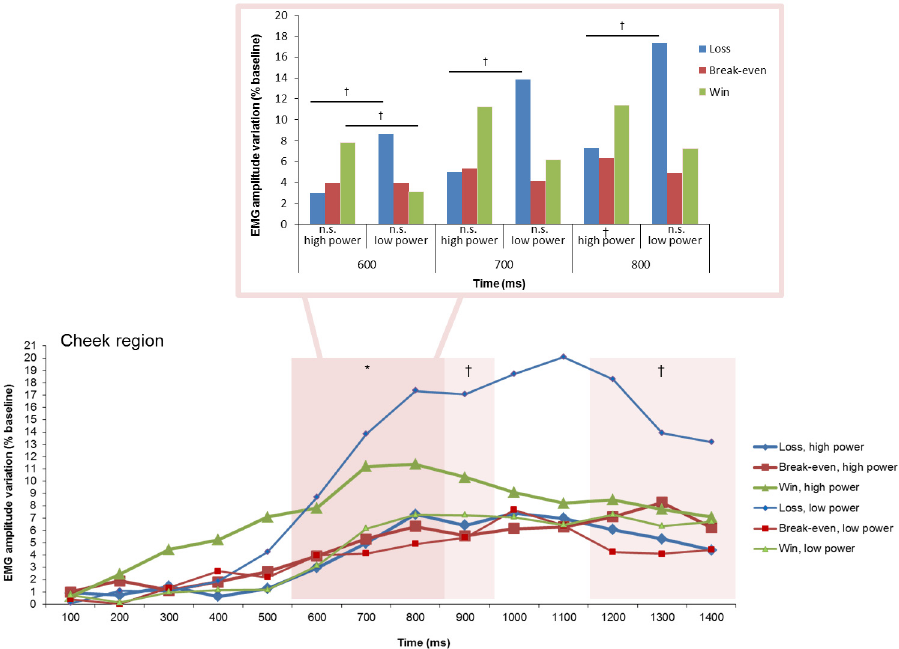
Fig 6. Electromyographic (EMG) amplitude variations over the cheek region, illustrating the interaction of goal conduciveness and power appraisals across time. † p < .10, * p < .05.